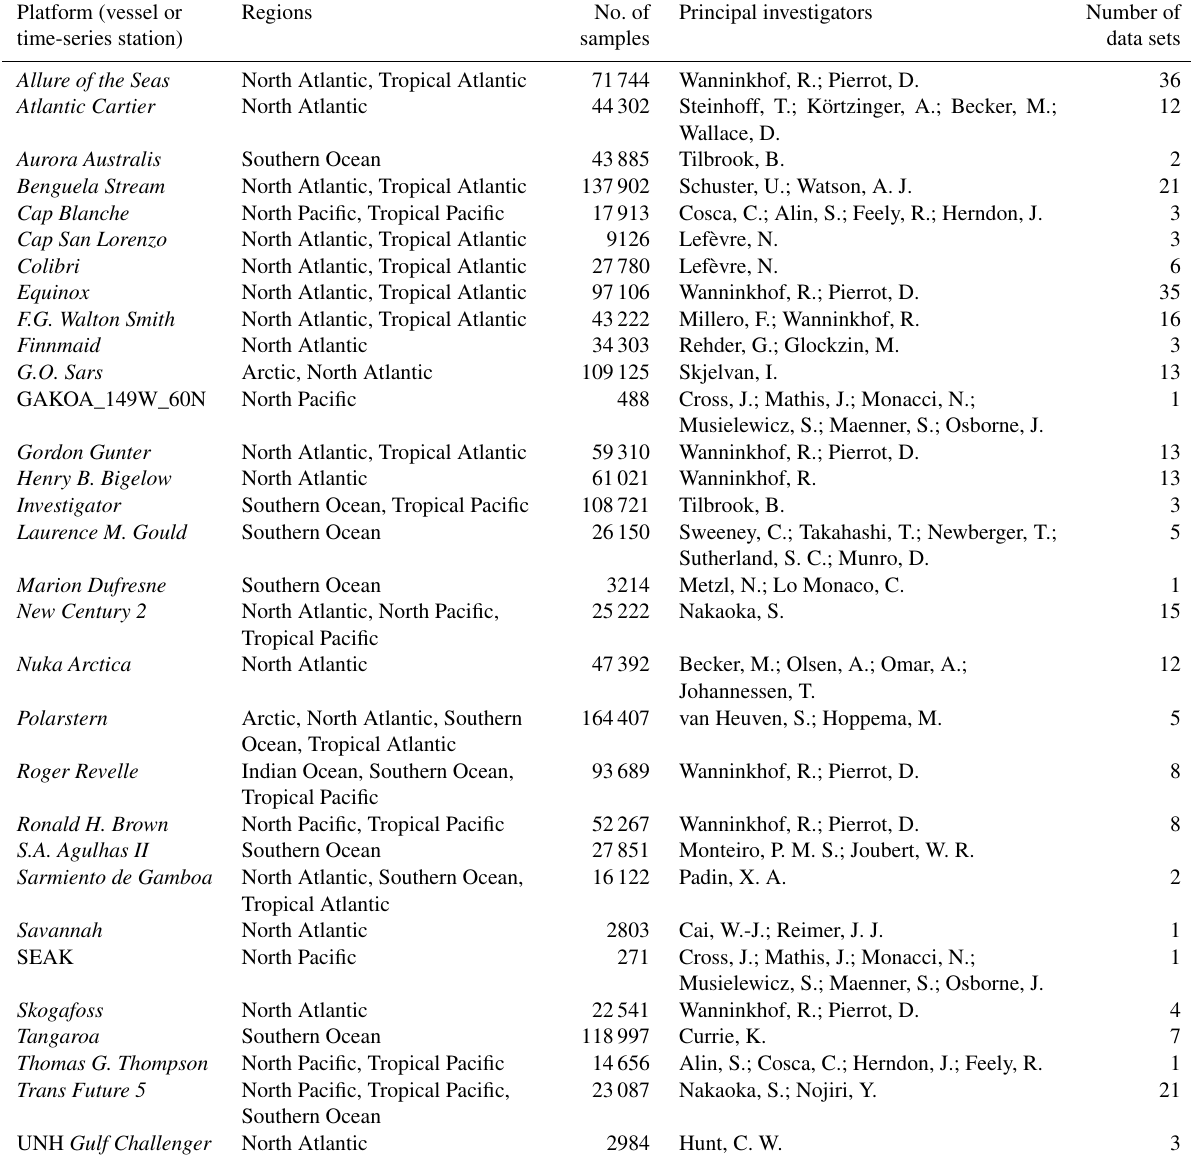
Table A4. Attribution of f CO 2 measurements for the year 2016 included in SOCAT v5 (Bakker et al., 2016) to inform ocean p CO 2 -based flux